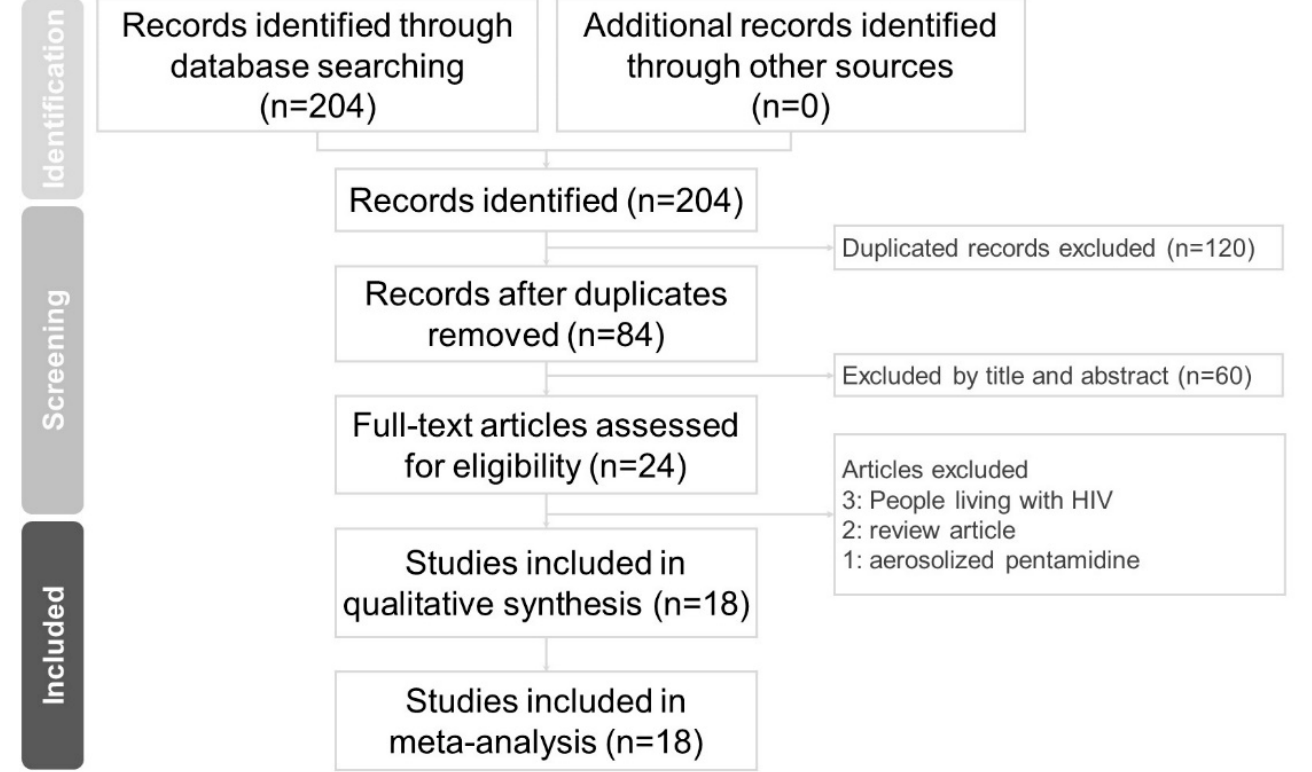
Figure 1. PRISMA flow diagram for study Figure 1. PRISMA fl ow diagram for study selection.